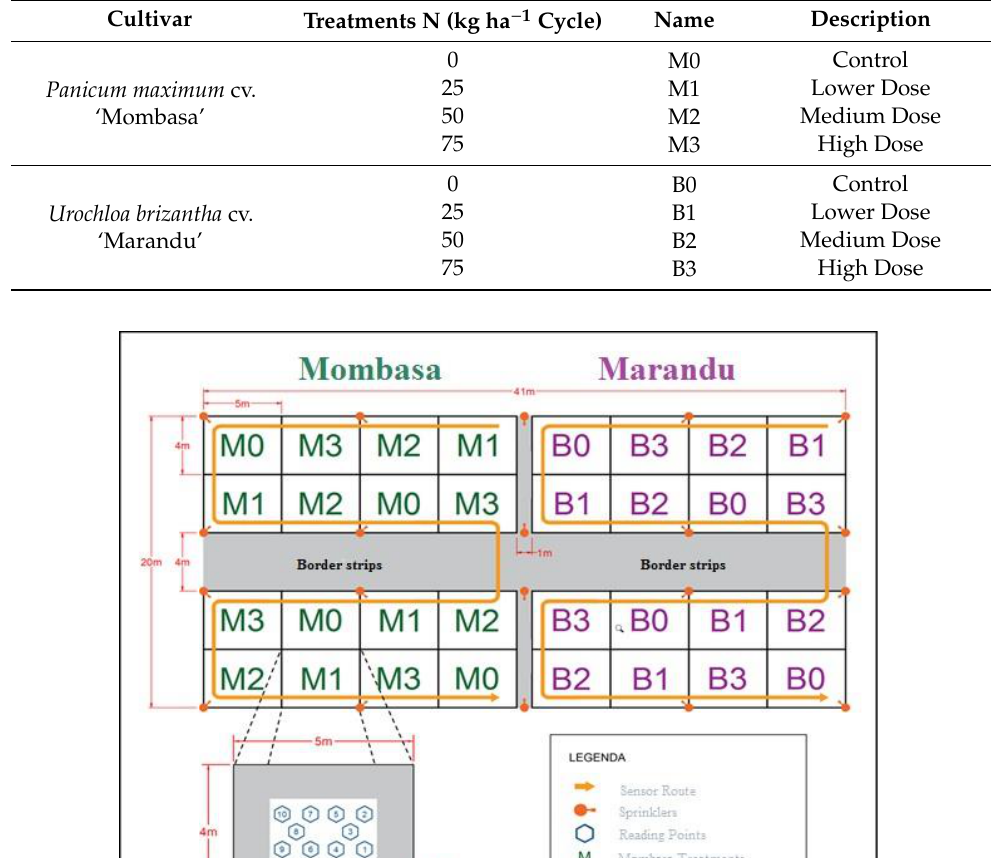
Table 1. Description of experimental treatments for Mombasa (M) and Marandu (B). Cultivar Treatments N (kg ha − 1 Cycle) Name